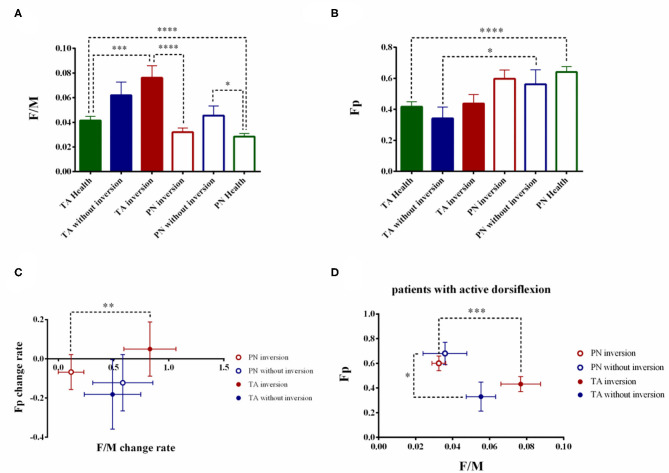
The stratified analysis based on foot inversion. The comparison of F/M (A) and Fp (B) based on foot inversion. The stroke patients were divided into two groups based on the foot inversion. The change rate of the F/M and Fp were also calculated (C). To eliminate the interfered of the biomechanics factor, the patients with active dorsiflexion were extracted and the stratified analysis according to the foot inversion were conducted. (D) (*p < 0.05, **p < 0.01, ***p < 0.001, ****p < 0.0001; error bar:1 SEM).